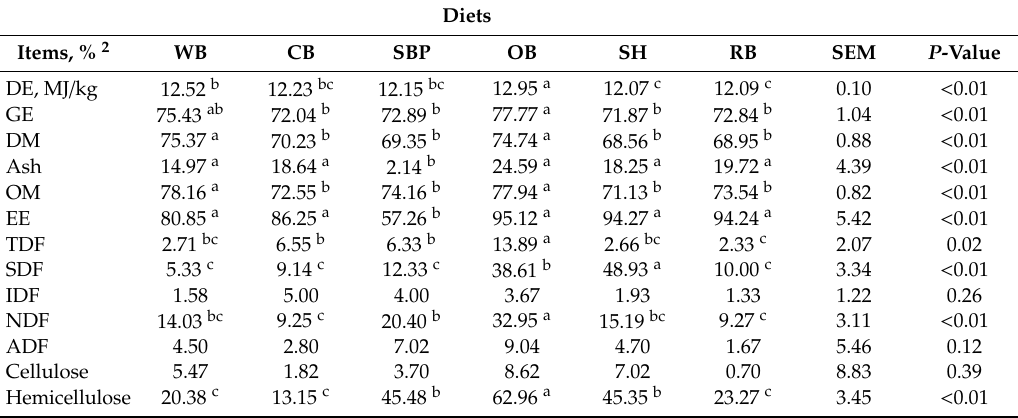
Table 3. The AID values of chemical components for pigs fed diets with di ff erent high-fiber ingredients 1 .